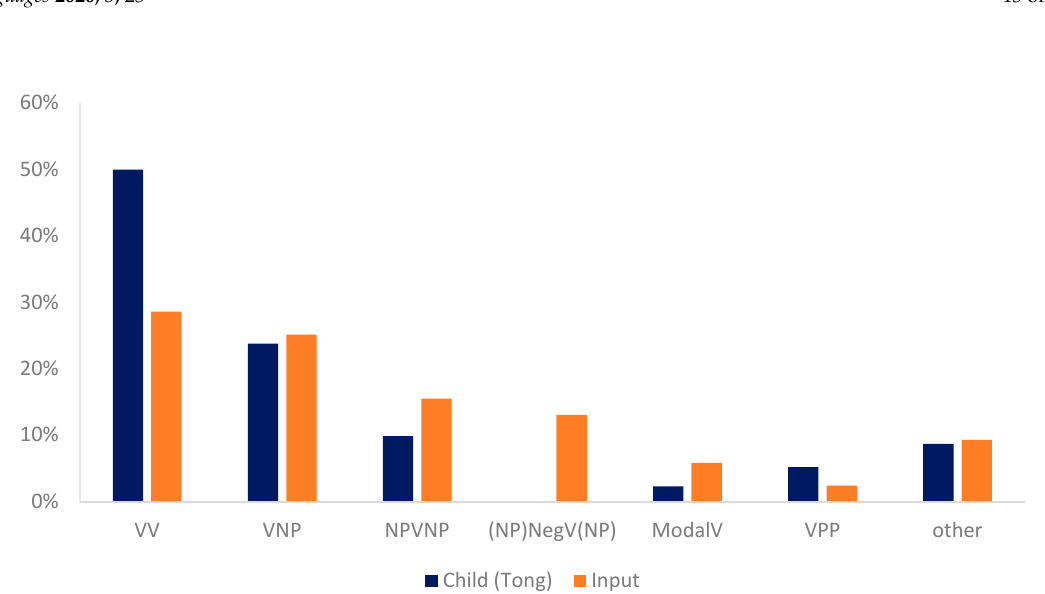
Figure 6. Proportions of syntactic frames of 打 d ǎ in Tong’s and his caregiver’s speech. (VV = verb compound; VNP = verb followed by an object noun phrase; NPVNP = subject noun phrase followed by the verb and an object noun phrase; VPP = verb followed by a prepositional phrase) 5 .